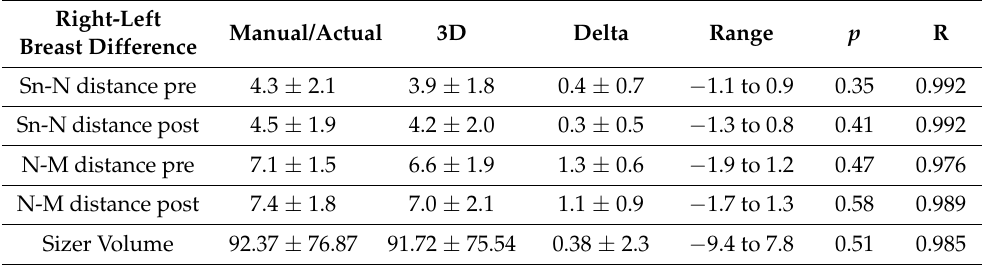
Table 4 showing the difference of Sn-N and N-M and sizer volume between right breast and left breast at the beginning (pre) and end (post) of surgery, their respective delta and range of deviation with p -value and correlation coefficient (R). The distance measurements are given in millimeters with their respective ± standard deviation. The volume measurements are given in cubic centimeter with their respective ± standard deviation. Breast symmetry for implanted sizers was 4.97 ± 4.07 mm RMSE and significantly differed from breast symmetry in postoperative outcome ( p =